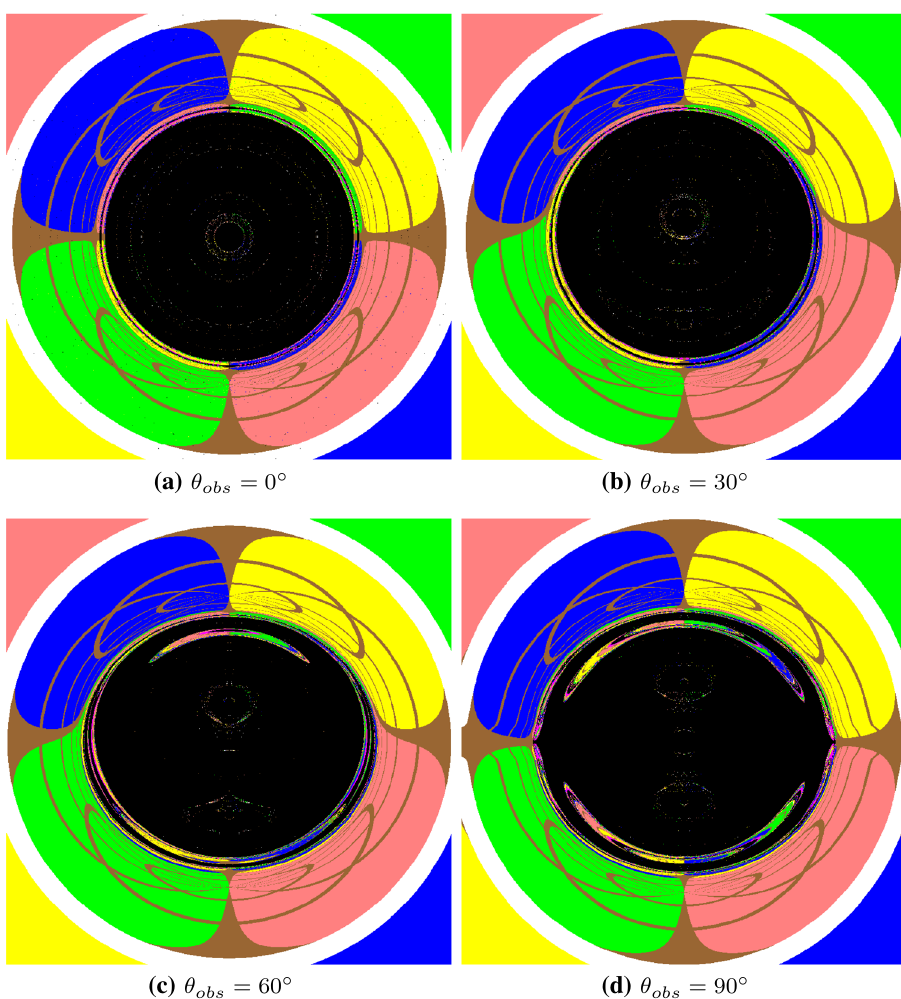
Fig. 3 The shadows of Schwarzschild black hole surrounded by Bach–Weyl ring for the observers with different inclination angle. Here we set M = 1 . 5 M and Weyl radius b = 3